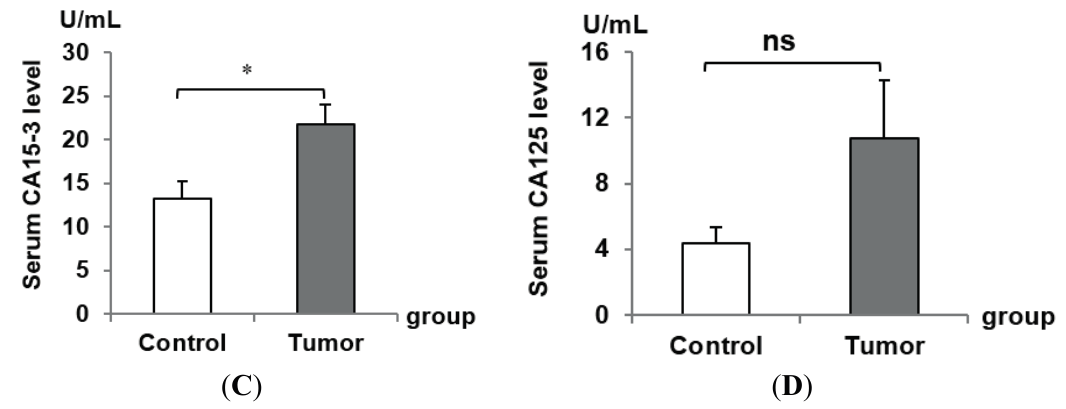
Figure 3. Serum level of HE4, carbohydrate antigen 19-9 (CA19-9), carbohydrate antigen 15-3 (CA15-3), and carbohydrate antigen 125 (CA125) were examined in normal controls and pancreatic adenocarcinoma patients. The average serum levels of HE4 ( A ); CA19-9 ( B ); CA15-3 ( C ); and CA125 ( D ) were measured with ELISA kit. A significant increase of HE4, CA19-9, CA15-3, respectively, was observed in pancreatic adenocarcinoma patients’ serum compared to normal control serum (* represents p < 0.05; ** represents p < 0.01), but not for CA125 (ns represents no significance).